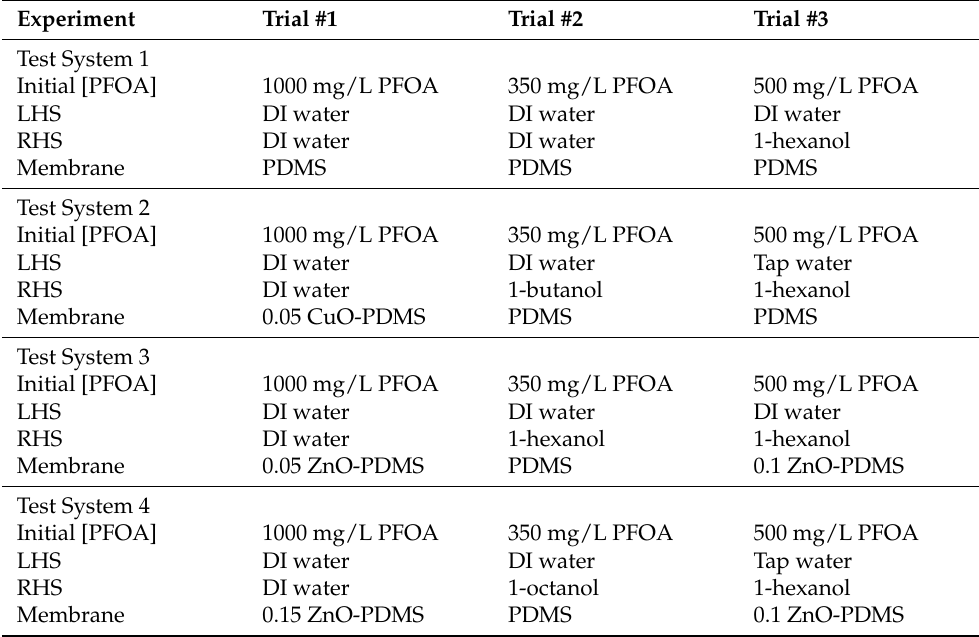
Table 1. Summary of tests conducted with four identical perstraction test systems.